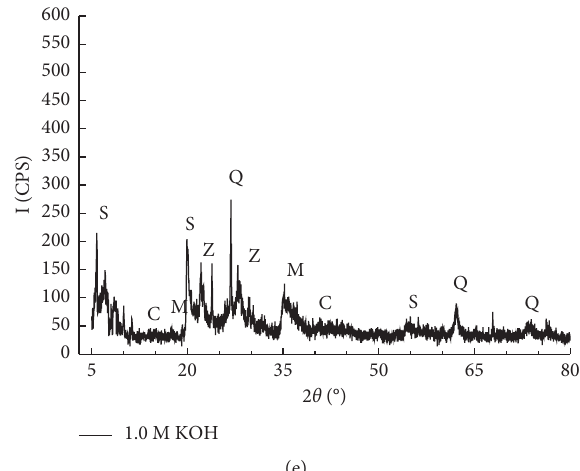
Figure 4: XRD diffraction pattern of bentonite sample: (a) distilled water, (b) 0.3M NaOH, (c) 1.0M NaOH, (d) 0.3 M KOH, and (e) 1.0 M KOH.